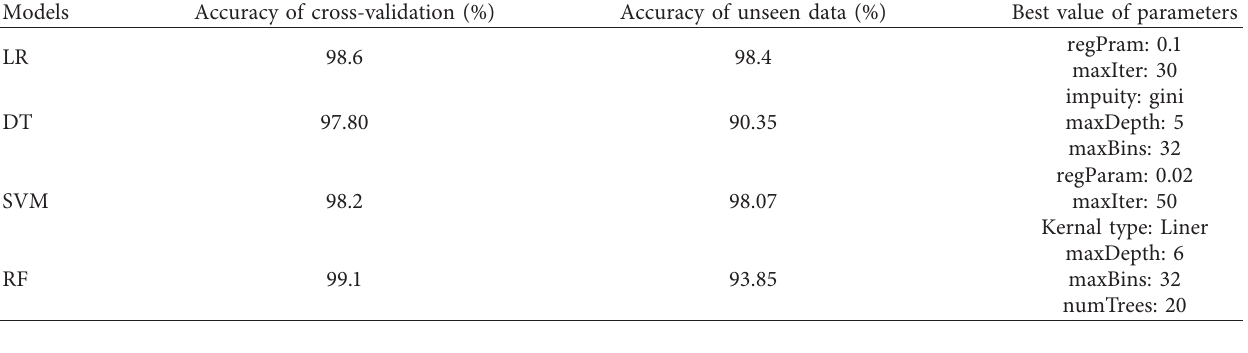
Table 5: Cross-validation result of ML models that are applied to features selected by univariate. Models